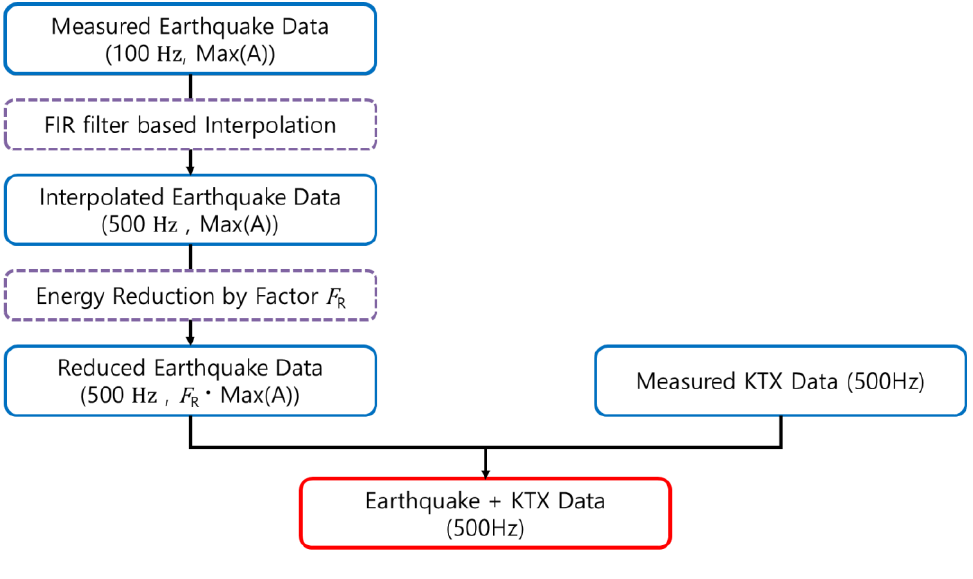
Figure 3. Data synthesis flow chart.